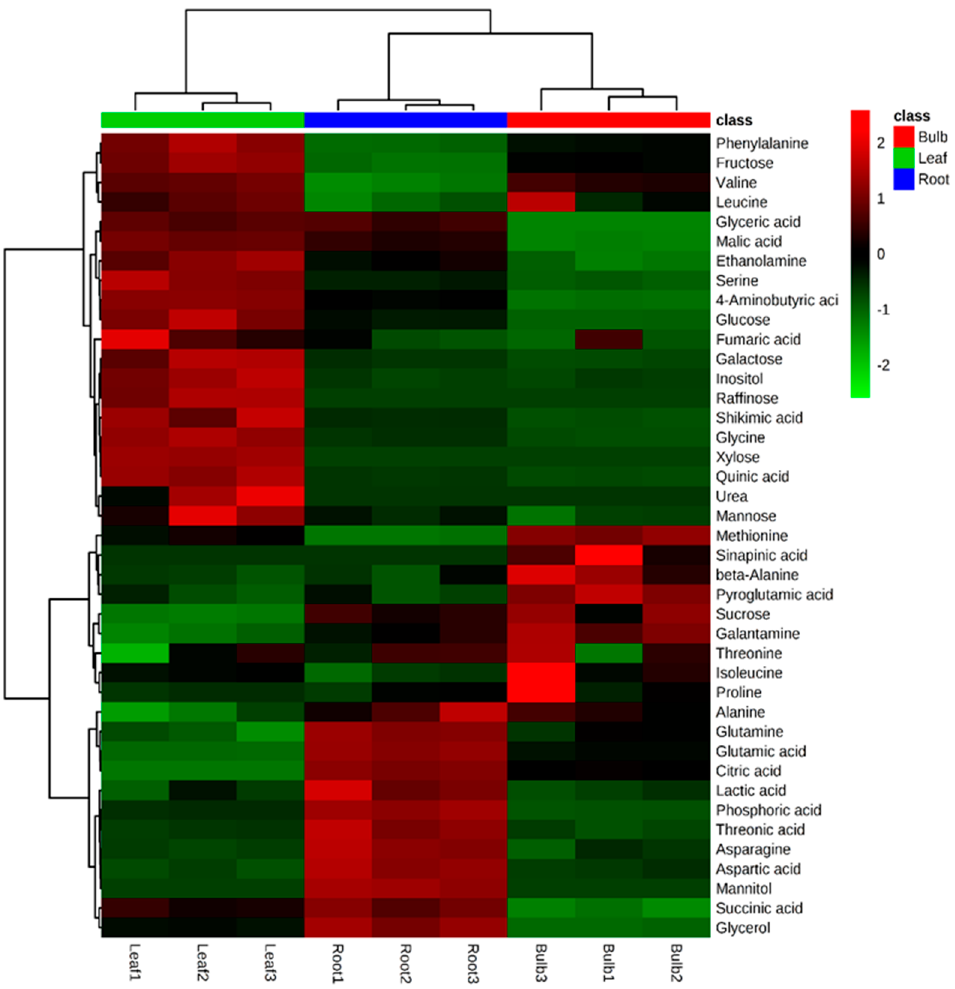
Figure 6. Heatmap representing di ff erences in relative metabolite concentrations of L. radiata grown in a growth chamber. Increasing and decreasing the contents of metabolites are shown by red and green color, respectively.